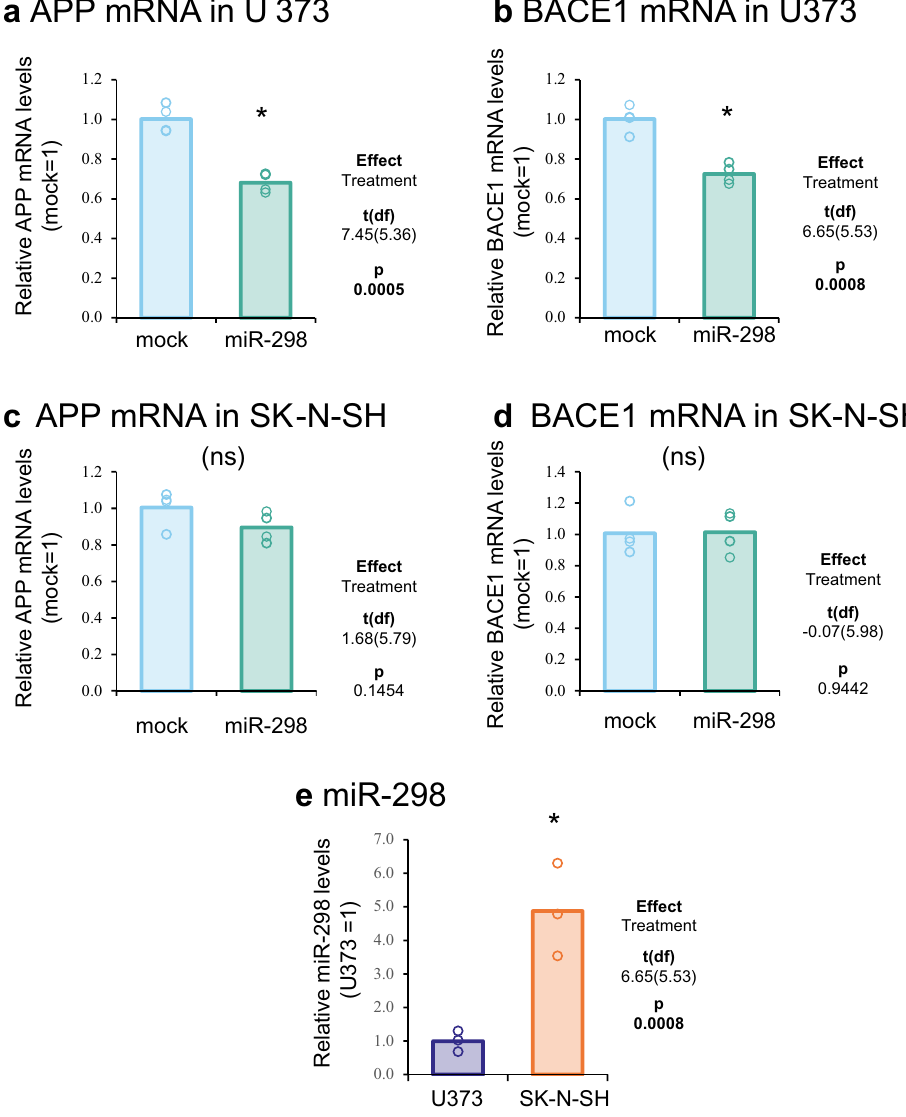
Figure 2. Effects of miR-298 treatment on APP and BACE1 mRNA in astrocytes and differentiated neuroblastoma cells. ( a , b ) Astrocytes were transfected with miR-298 for 3 days. RNA was harvested for reverse transcription and following quantification by real-time qPCR. APP and BACE1 mRNA showed significant reduction when transfected with miR-298. ( c , d ) Real-time qPCR analysis in differentiated neuroblastoma cells transfected with miR-298. ( e ) Quantification of endogenous miR-298 levels in astrocytes U373 and NBRA differentiated SK-N-SH. MiR-298 levels were normalized with the geometric means of miR-16, RNU48 and RNU6B. Significant pairwise difference indicated by